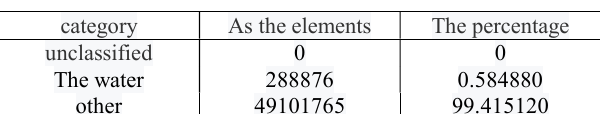
Table 4-2 Statistical results of surface water distribution in